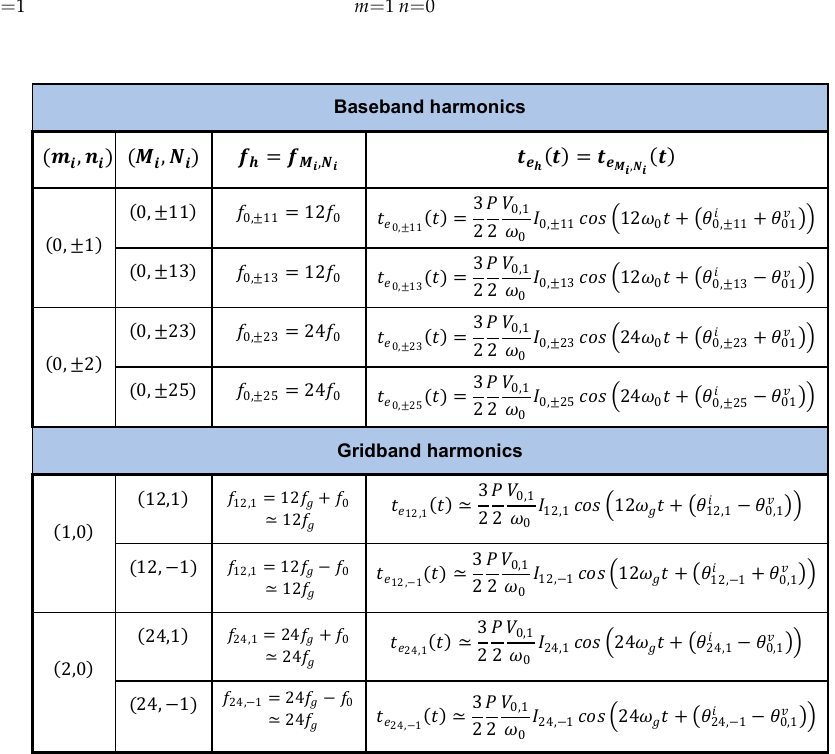
Figure 7. Harmonic families in a 12/12-pulse LCI system: baseband and gridband families.